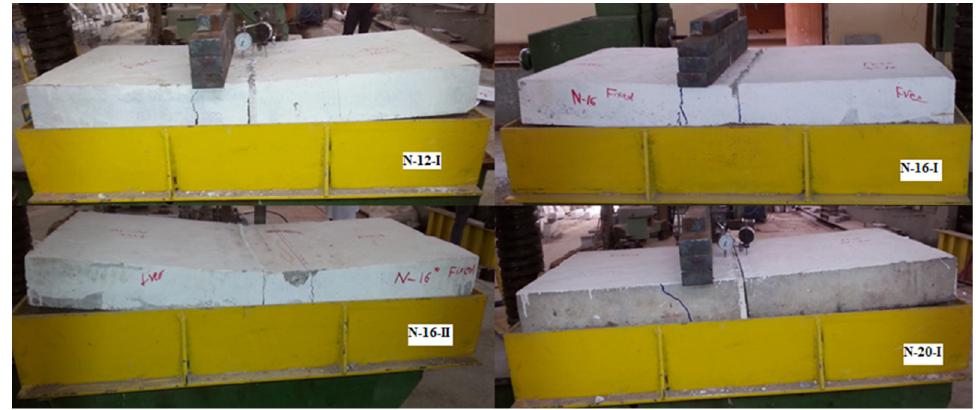
Fig. 6. The Tested Specimens at Failure.